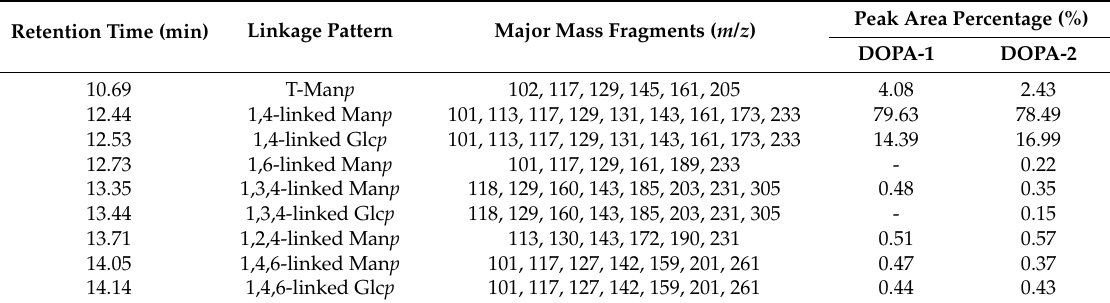
Table 2. Methylation analysis and of DOPA-1 and